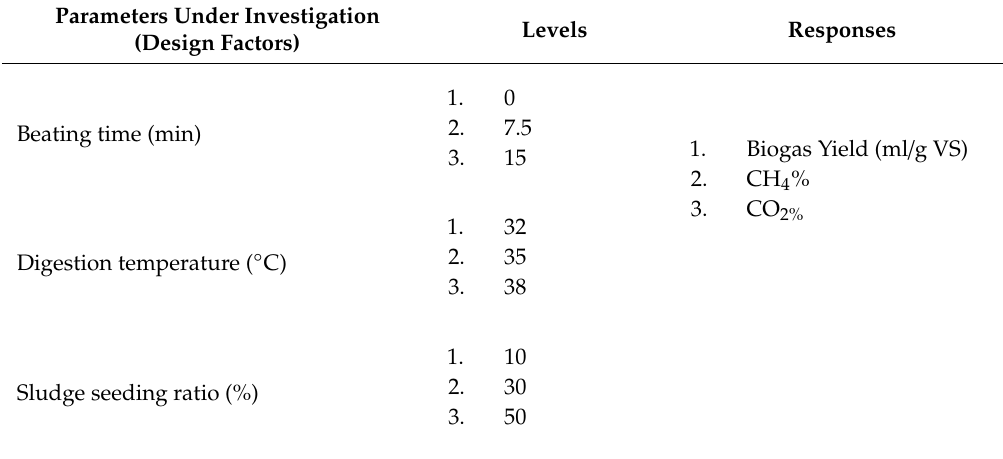
Table 1. Summary of the design factors, factor levels and the